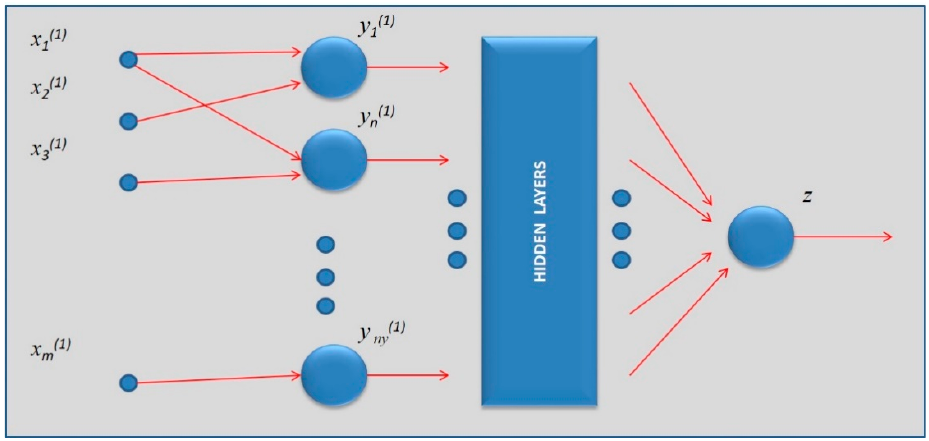
Figure 6. Structure of a feed-forward double-layer network [6]. Table 1. The results of training and testing the neural network in the form of root mean squared erros (RMSE). Bipolar Function Unipolar Network Architecture